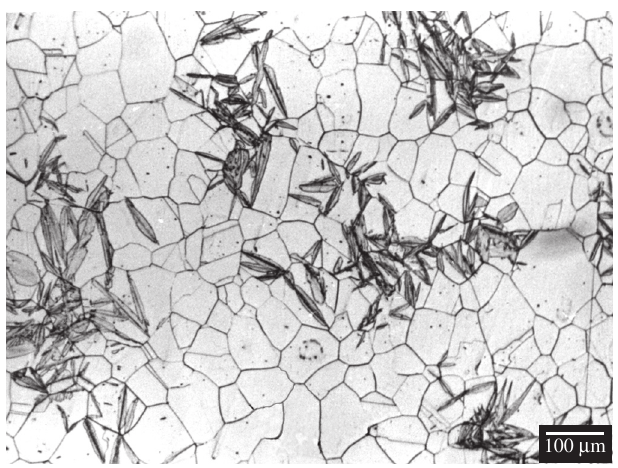
Figure 1. Optical micrograph of a Fe-31 wt. (%) Ni-0.01 wt. (%) C alloy transformed at M (220 K). The martensitic ‘spread’ can be clearly seen against s the background of austenite